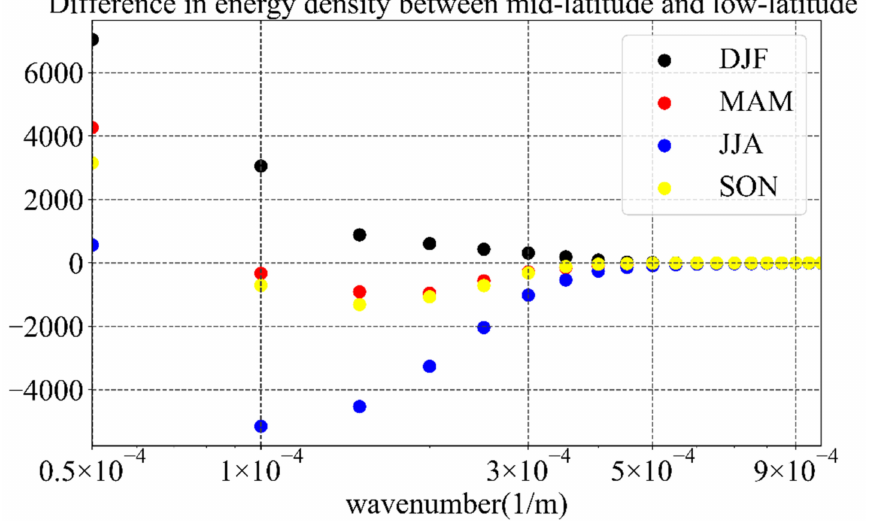
Figure 3. Variations in the differences of the energy density between the middle and low latitude regions as a function of vertical wavenumber in each